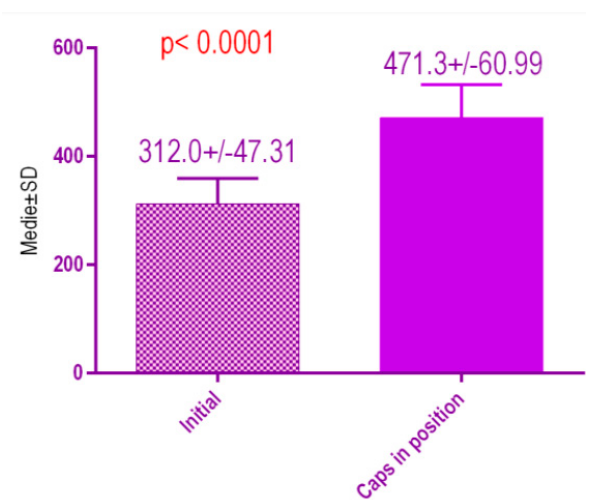
Figure 20. Bone radiodensity in the study groups, patients with orthodontic therapy in medical history, before vs. after treatment with conventional healing caps.